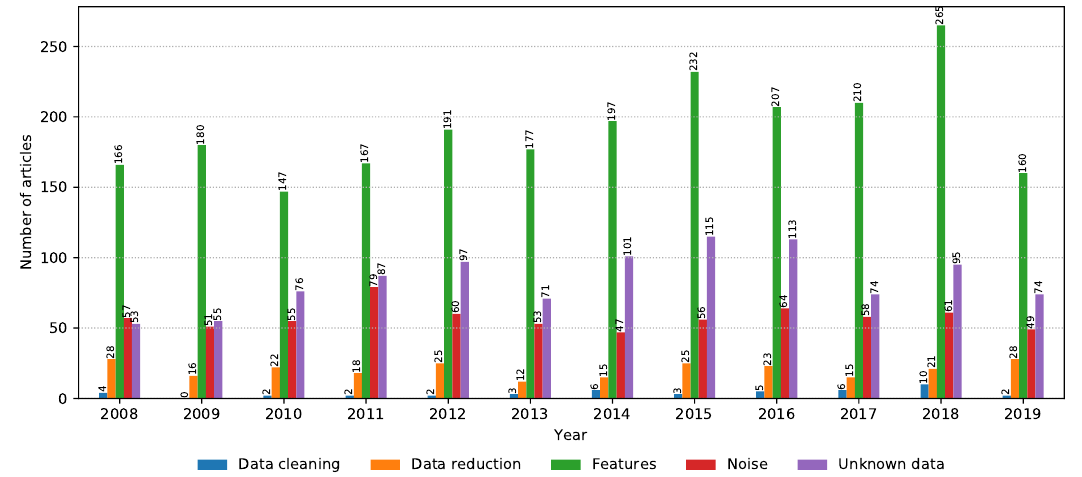
Figure 14. Number of relevant articles containing each property grouped into the data preprocessing